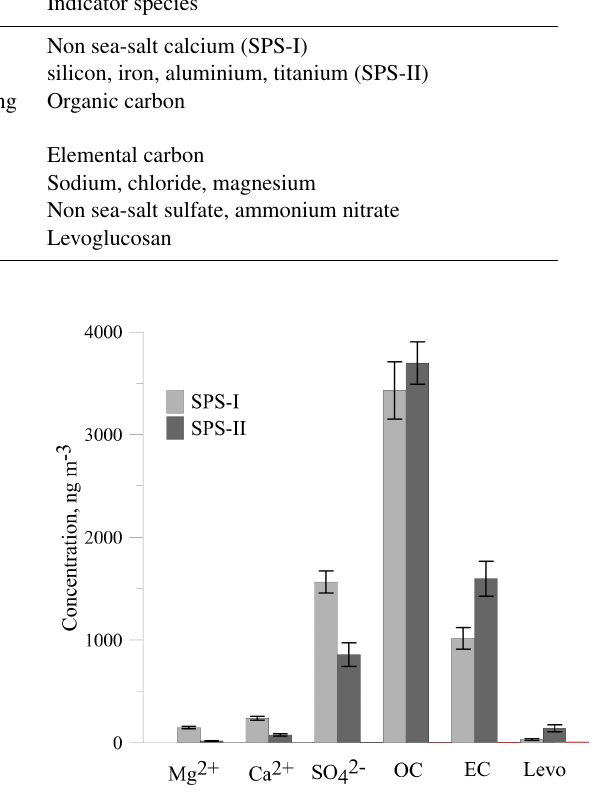
Figure 25. Comparison of average concentrations of Mg 2 + (a marker for sea-salt), Ca (a marker for soil), SO 2 − (a marker for sec- 4 ondary aerosol), OC, EC and levo = levoglucosan (biomass burn- ing marker) during SPS-I and SPS-II. Error bars represent stan- dard error (standard deviation/square root of number of observa- tions). Mg 2 + , Ca 2 + , and SO 2 − are significantly greater during 4 SPS-I ( p (cid:28) 0 . 05), OC is not significantly different between SPS-I and SPS-II ( p = 0 . 4), EC and levoglucosan are significantly greater during SPS-II ( p = 0 . 003 EC and p = 0 . 004